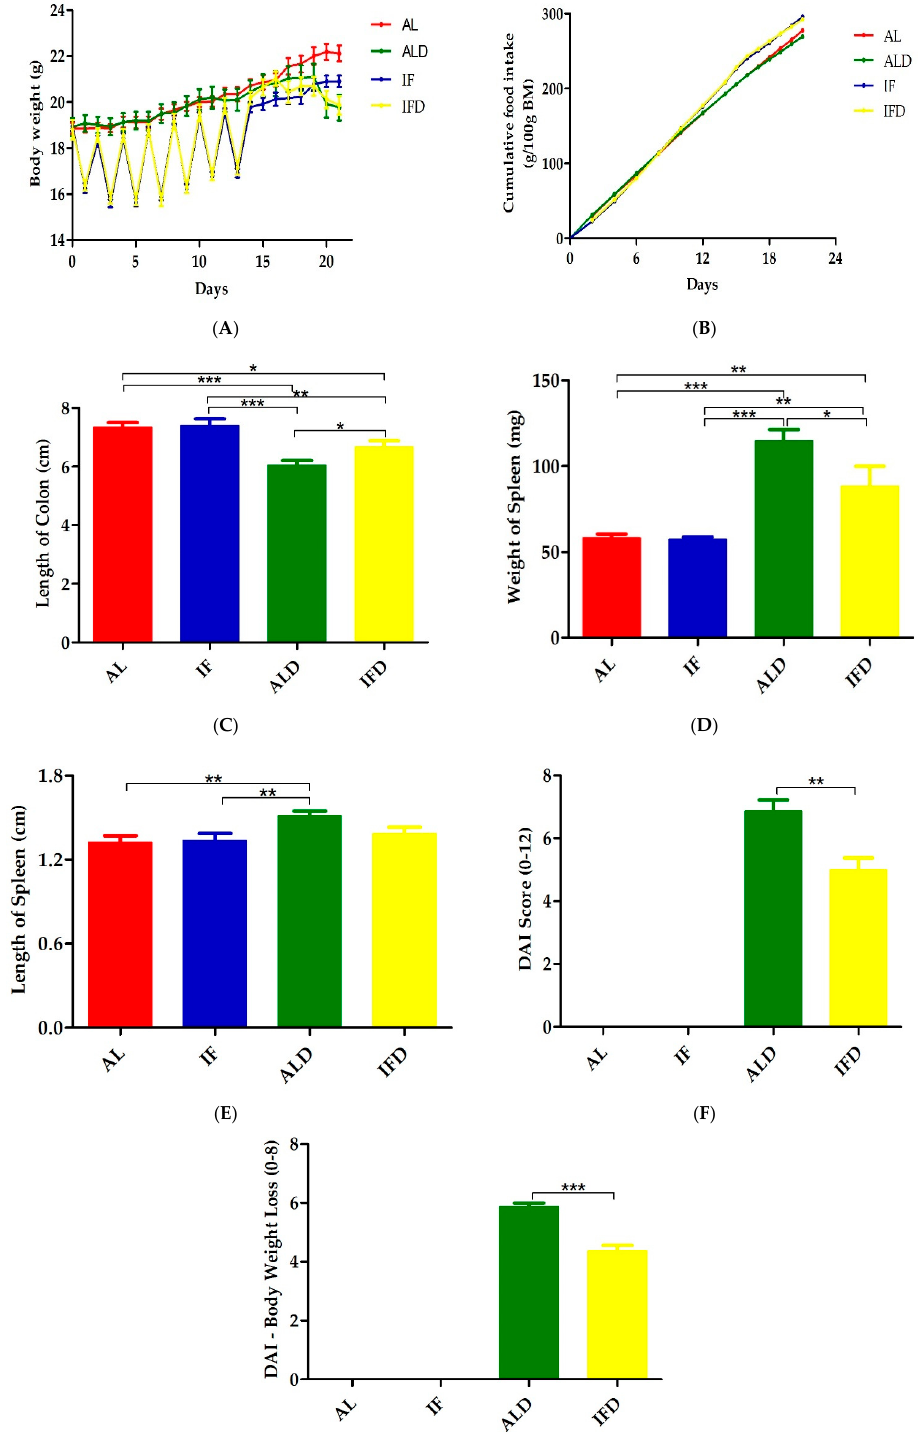
Figure 5. IF alleviates symptoms induced by DSS : ( A ) Body weight; ( B ) Cumulative food intake; ( C ) Colon length; ( D ) Spleen weight; ( E ) Spleen length; ( F ) DAI score; and ( G ) Modified DAI score. AL: ad libitum-fed group; IF: intermittent fasting group; ALD: ad libitum-fed group with DSS; IFD: intermittent fasting group with DSS; DAI: Disease activity index; BM: Body mass. * p < 0.05, ** p < 0.01, *** p < 0.001.